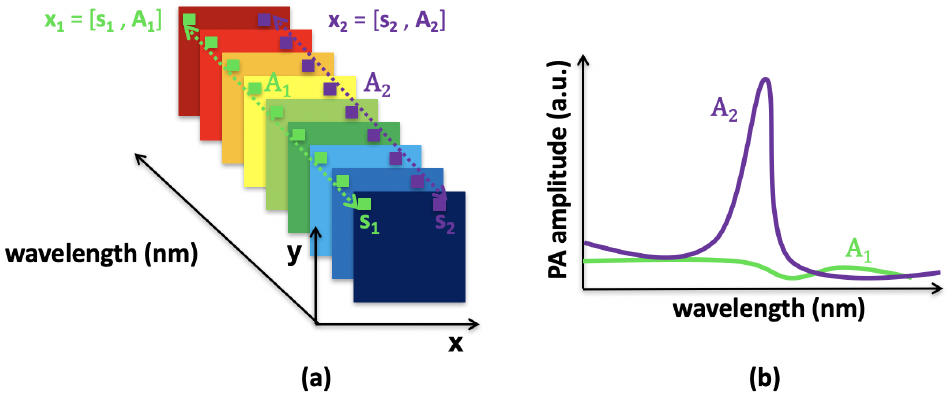
Figure 1. Multispectral photoacoustic image. ( a ) The signals are acquired at several wavelengths. Two pixels are identified: x 1 in green, and x 2 in purple. ( b ) Spectra of the pixels x 1 and x 2 : A 1 (in green) is a background pixel with low and flat photoacoustic amplitudes at all wavelengths, and A 2 (in purple) is a pixel with significant photoacoustic amplitudes (a.u., arbitrary